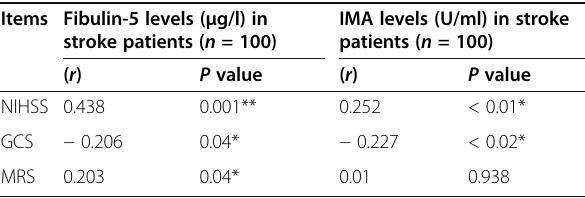
Table 9 Correlations between fibulin-5 and IMA levels